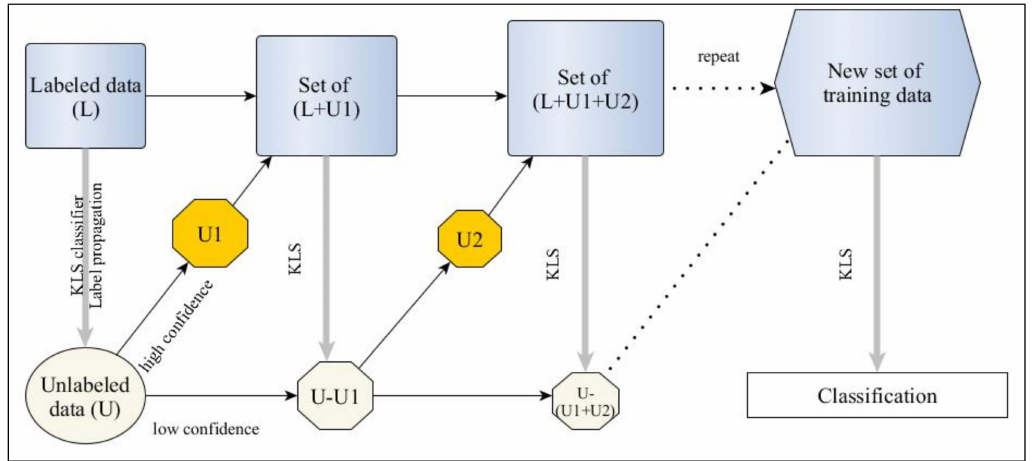
Figure 3. Flowchart of classification using the combination of self-learning with kernel least squares classifier in this